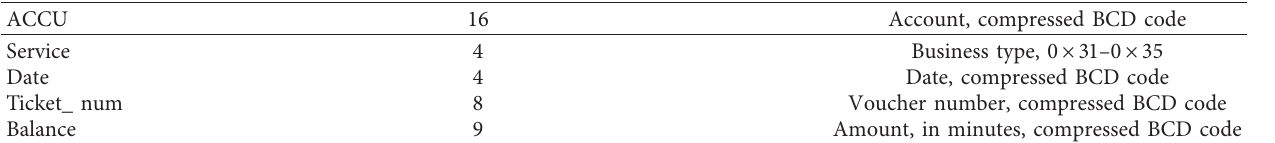
Figure 5: System Table 1: Plaintext format of the payment password.